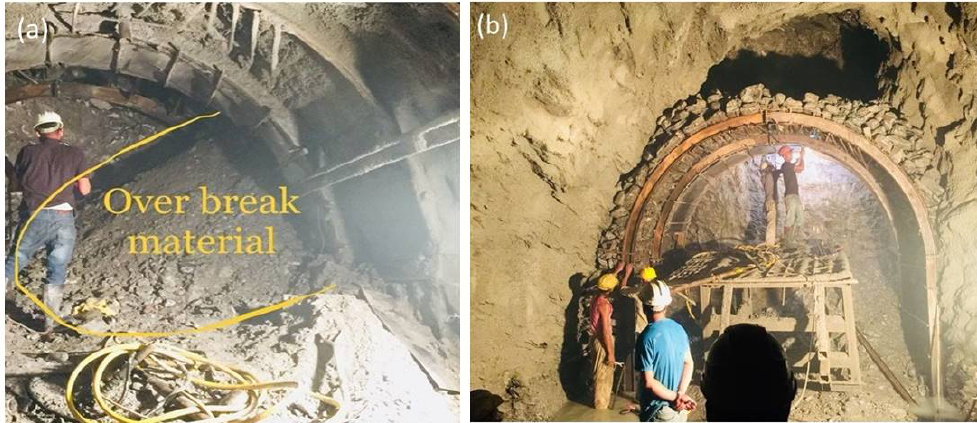
Figure 8. ( a ) Loose material reeling down from the sidewall in DKHP; ( b ) overbreak filling in